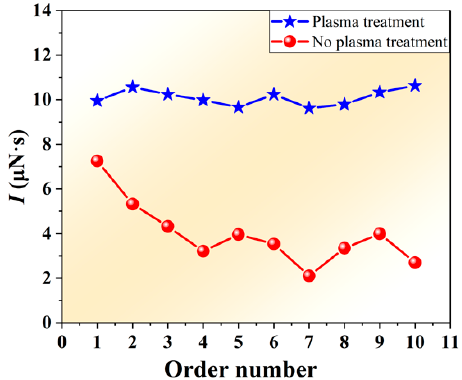
Figure 9. Comparison of I of continuous ten ablations. The blue line showed the result of the I after plasma treatment. I of the tape with plasma treatment was more stable and less volatile. The red line showed the result of the I without plasma treatment. The I of the tape without plasma treatment decreased obviously and was very unstable.